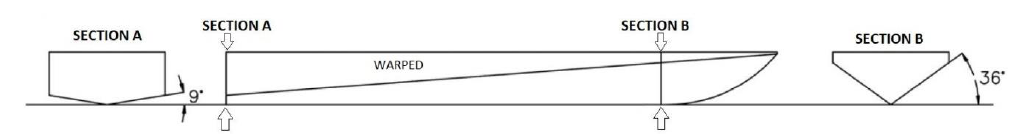
Figure 1. The 2D geometries of the mono hull.